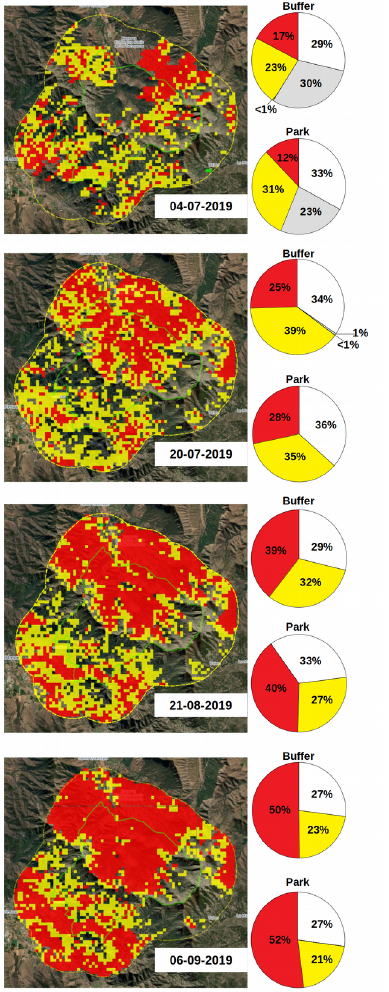
Figure 4 . Warning system showing the effects of the 2019- 2020 drought. red=alert (P >0.95); yellow=warning (P[0.75-0.95]); no color= normal (P<0.75); grey=clouds.